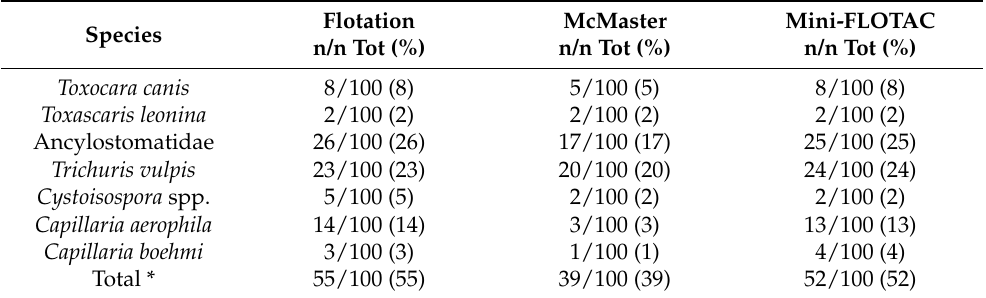
Table 1. Number (n) and percentage (%) of dog fecal samples that scored positive using each technique out of the total number of tested samples (n tot).